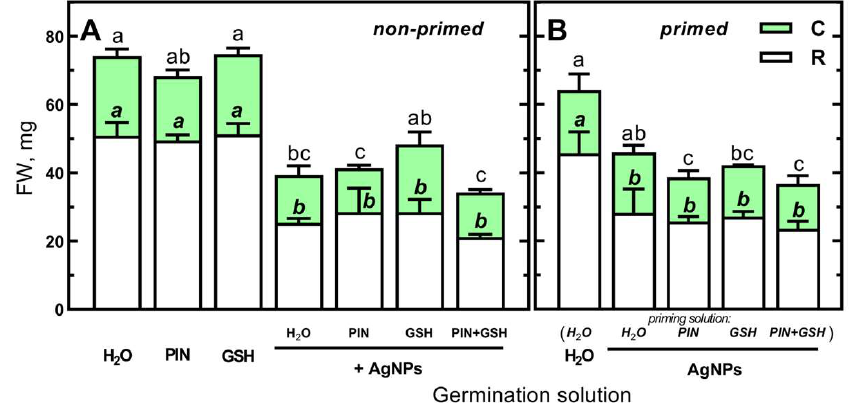
Figure 8. ( A ) The effects of PIN (50 mM), GSH (12.5 mg/L) and (Bio)Ag NPs (at 40 mg/L) alone and in mixtures of PIN, GSH and PIN plus GSH on the fresh weight (FW) of roots ( R , including scutellum) and coleoptiles ( C ) of 3-day-old seedlings of wheat ( Triticum aestivum L. cv. Collada). ( B ) The effects of wheat grains priming in H 2 O, PIN, GSH and mixtures of PIN and GSH on the FW of roots and coleoptiles of 3-day-old seedlings of wheat developing in H 2 O or (Bio)Ag NPs (at 40 mg/L). Values are means ( n = 3) + SD. Bars with the same letters (a–c) were not significantly ( p < 0.05) different after ANOVA test and Tukey’s post hoc corrections.